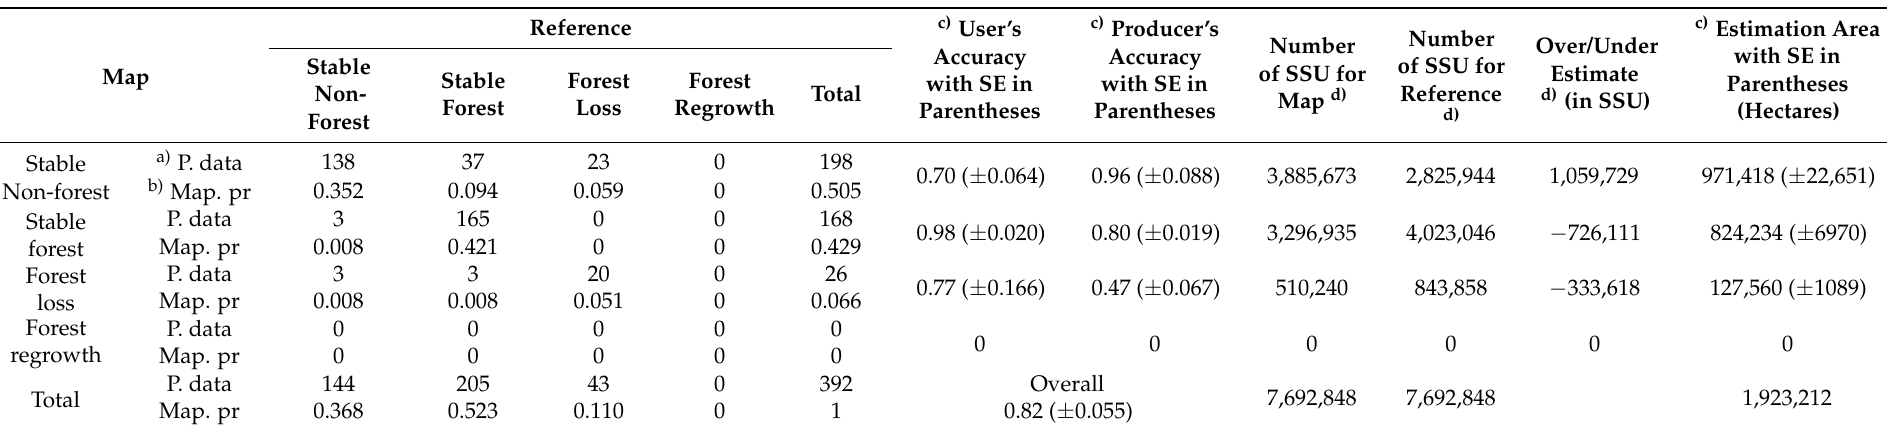
Table A2. Description of population data and map proportion area confusion matrix for the visual interpretation of land cover change map in 2000–2006.